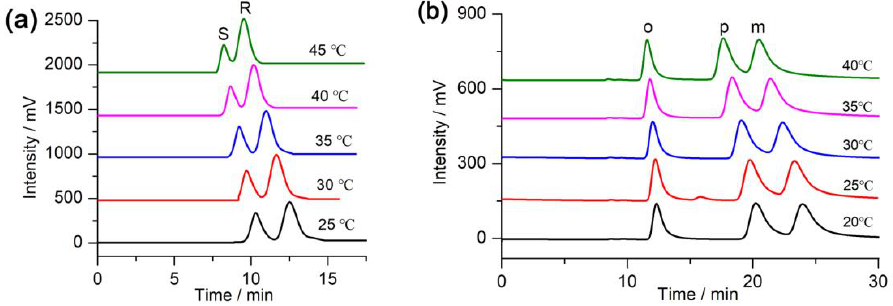
Figure 6. Separation of ( a ) hydrobenzoin and ( b ) iodoaniline on the column at different column temperatures. The other chromatographic conditions are the same as those in Tables 1 and 2.